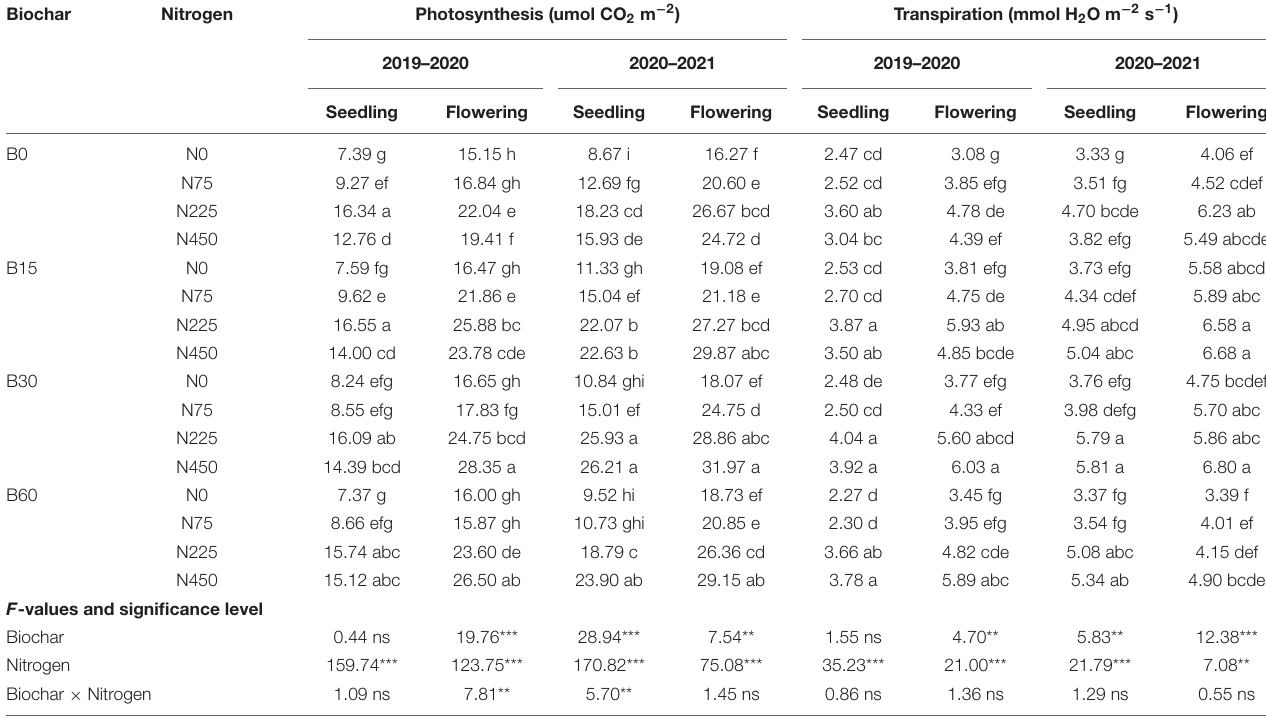
TABLE 5 | Integrated effect of biochar and nitrogen application on rapeseed photosynthesis and transpiration rates during 2019–2020 and 2020–2021.